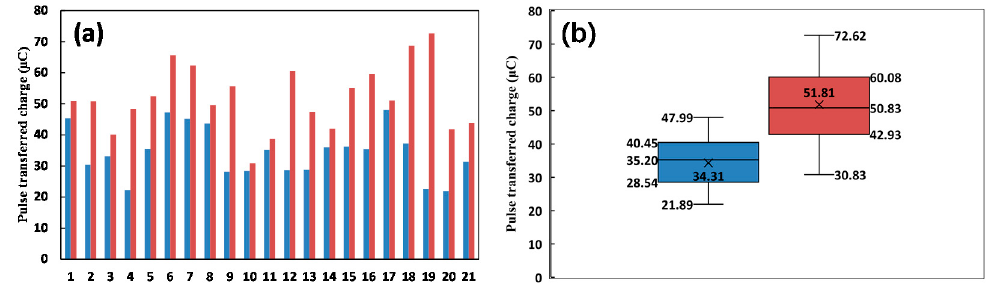
Figure 11. Average pulse transferred charge of PCP clusters and IPCPs. ( a ) Statistics of each case. ( b ) Overall statistics of all cases. The blue is the PCP clusters and the red is the IPCPs.